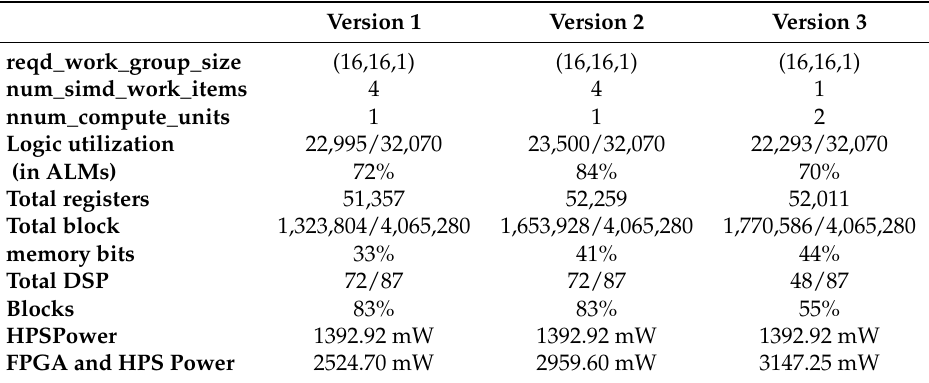
Table 2. Hardware resources of kernel